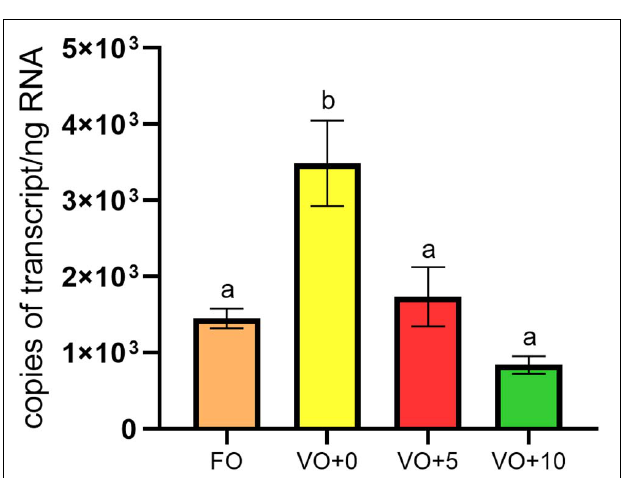
FIGURE 3 | Expression levels of (cid:49) 6-desaturase gene in fish liver. Data are means ± SEM ( n = 6). Different letters indicate significant differences between experimental diets as determined by one-way ANOVA with Tukey’s comparison test ( p <